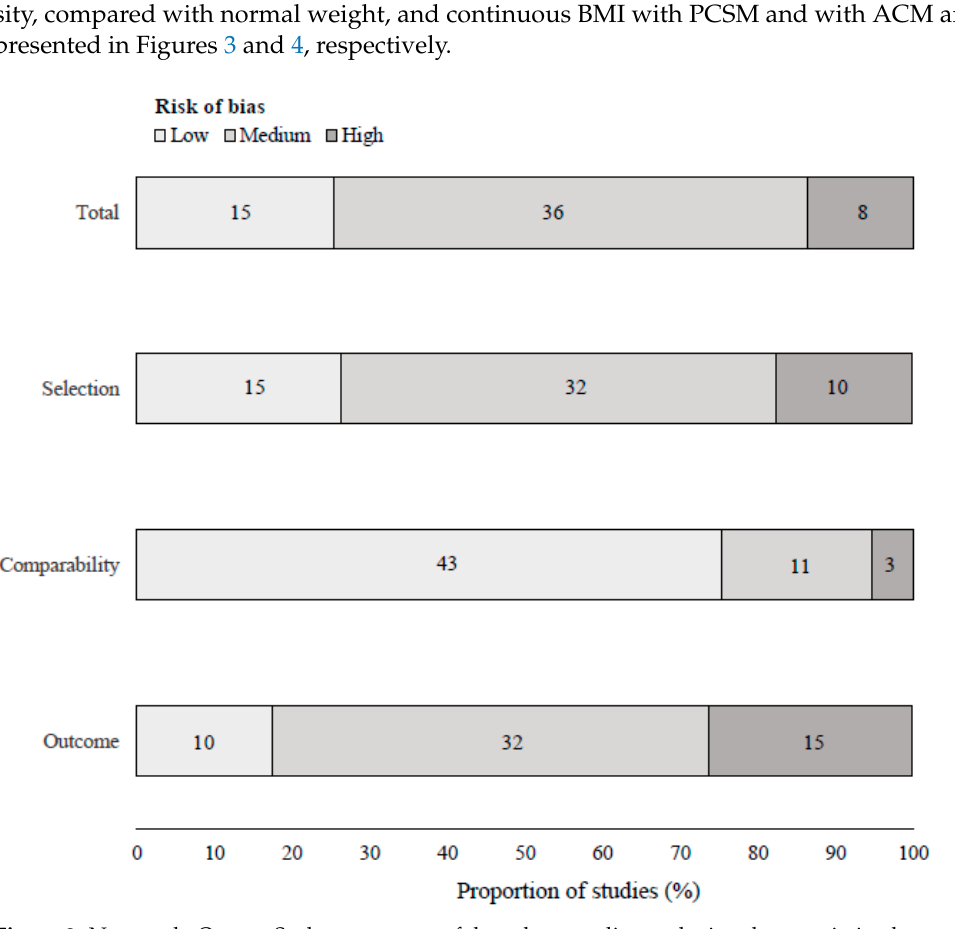
Figure 2. Newcastle-Ottawa Scale assessment of the cohort studies analyzing the association between obesity and mortality.